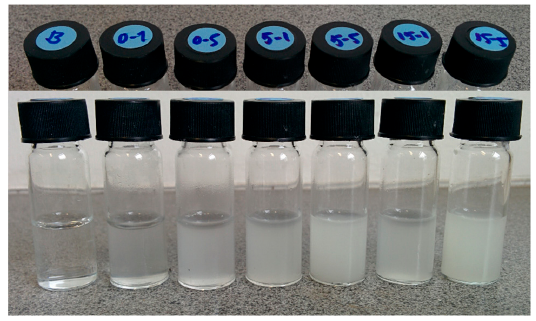
Figure 4. Images of MQ/PG (B) and of MSN–PEI (0–X), MSN–PEI–F5 (5–X) and MSN–PEI–F15 (15–X), X = 1 and 5 mg/mL.